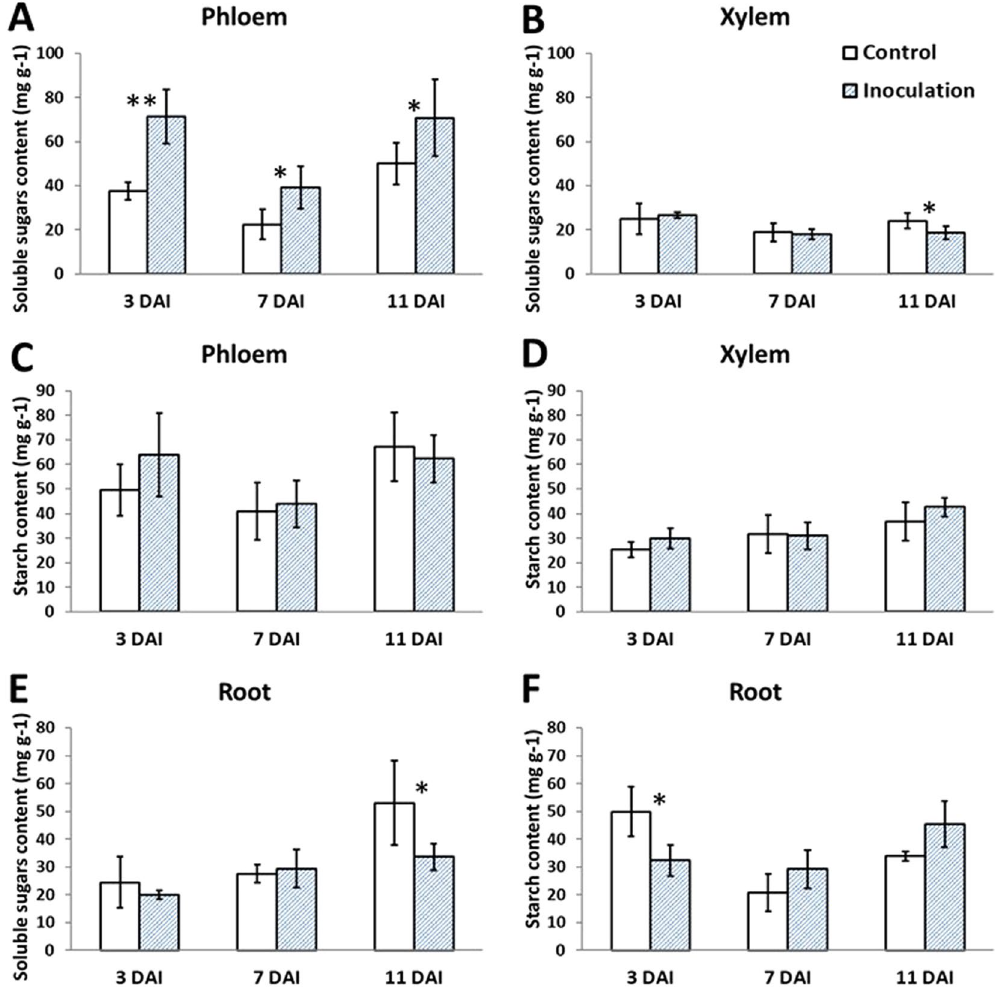
Figure 6. NSC contents in the stem phloem, stem xylem and roots in Botryosphaeria infected poplars. showed the content of soluble sugars in stem phloem and xylem, respectively. ( C , D ) Showed the starch content in stem phloem and xylem, respectively. ( E , F ) Showed the content of soluble sugars and starch in roots, respectively. Asterisks indicate treatments that significantly differed from control (ANOVA; * P < 0.05; ** P < 0.01; 6 biological replicates per